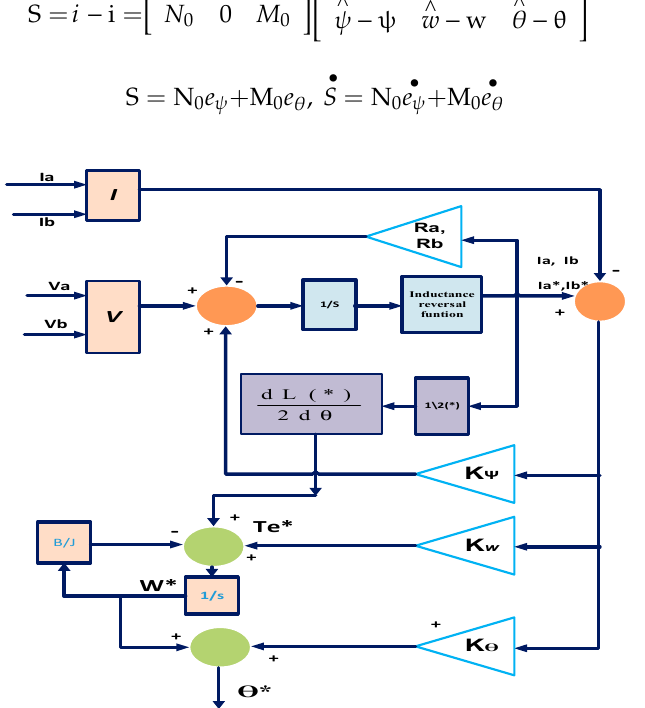
Figure 5. Block diagram of the sliding mode observer.